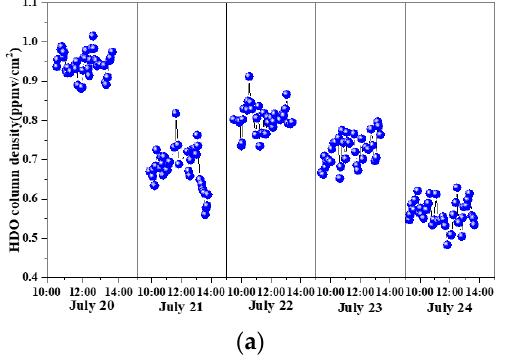
Figure 7. The measured spectra (black line), the retrieval fitting (red line), HDO fitting (green line), CH 4 fitting (blue line) and the residual (light blue line). The HDO and methane column densities from 20 to 24 July are shown in Figure 8. During the measurement campaigns, the column density of HDO was only about 0.5~1.0 ppmv and obviously decreased from 20 to 24 July. The methane column density at Dunhuang was 1.792 ± 0.005 ppmv and the maximum fluctuation of methane was on 20 July.